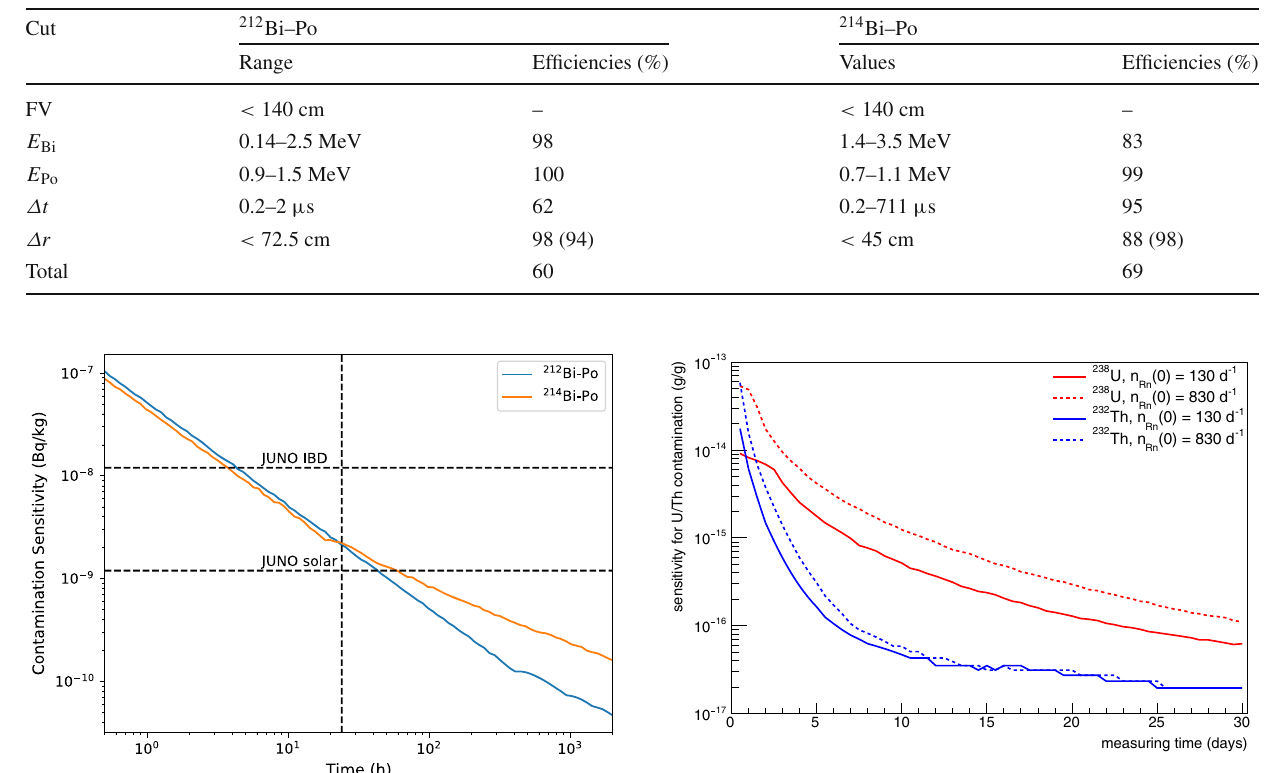
Table 7 Efficiencies of the different data selection cuts (see text). The fiducial volume is defined as a cylinder of 2.8m height and diameter, E Bi , Po are the energy windows selected for prompt and delayed decays,